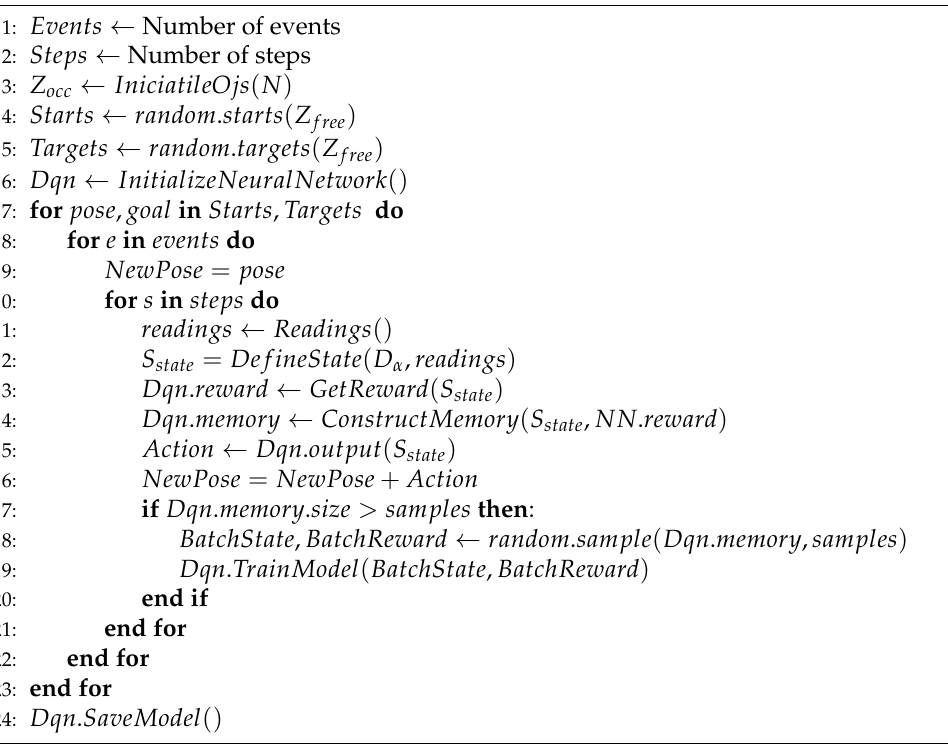
Algorithm 2 Simple environment DQN